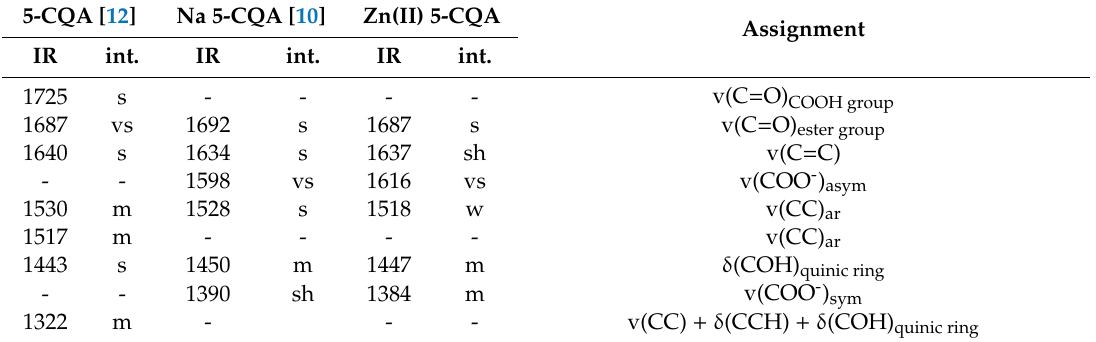
Figure 2. The FT-IR spectra of: ( a ) Zn(II) chlorogenate and ( b ) chlorogenic acid registered in the range of 400–4000 cm − 1 for solid samples in the KBr matrix pellet. Table 3. The wavenumbers, intesities and assignment of selected bands from the FT-IR spectra of zinc chlorogenate, sodium chlorogenate [10] and chlorogenic acid [12]; the symbols denote: ν -stretching vibrations, δ -deforming in plane and oop-out of plane bending vibrations; s-strong, m-medium, w-week, v-very, sh-on the slope.